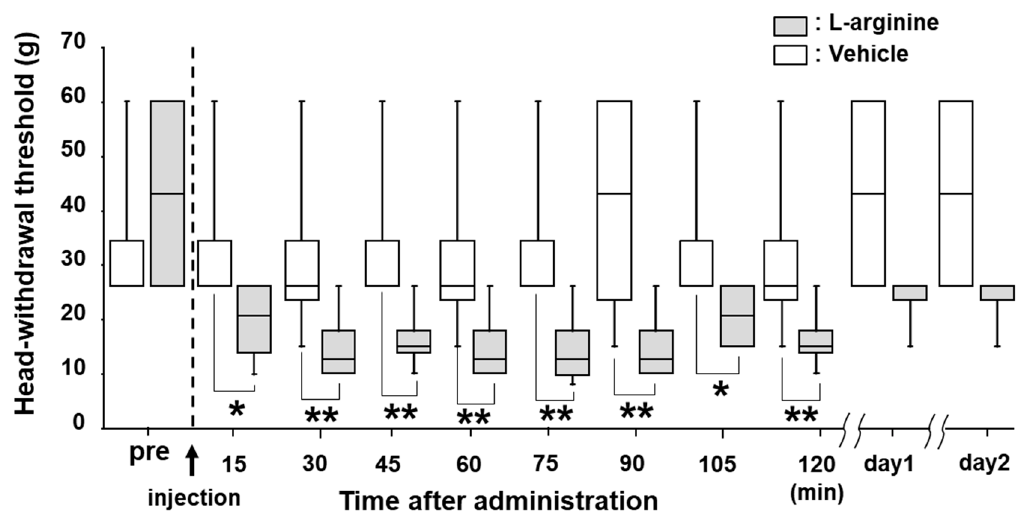
Figure 4. The e ff ect of L-arginine administration into TG on MHWT in naïve rats. Time-course change in HWT to mechanical stimulation of the whisker pad skin following L-arginine administration. *: p < 0.05, **: p < 0.01. n = 5 in each